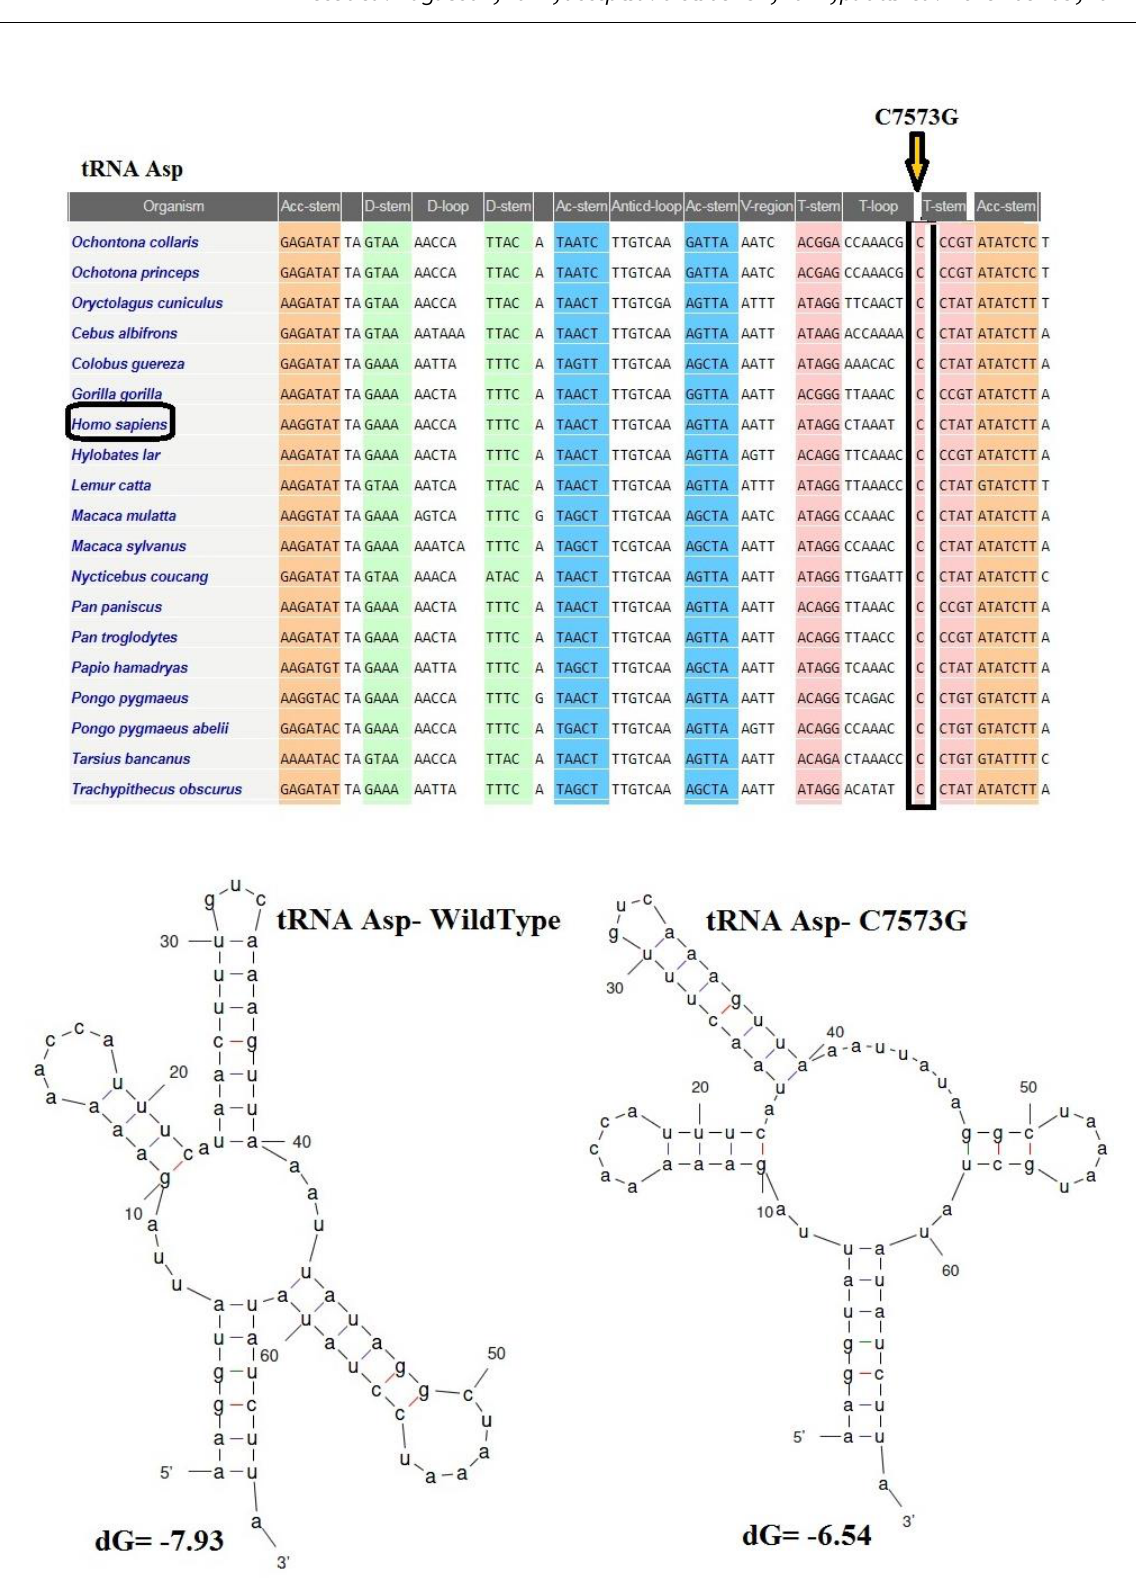
Figure 5: Sequence alignment of tRNA Asp reveals a high-degree of conservation of C7573 nucleotide across species. A representation of the structural and folding effect of the C7573G mutation in tRNA Asp was predicted using the Mfold program is also represented below the sequence alignment. The free energy change between the mutant and wild-type states was